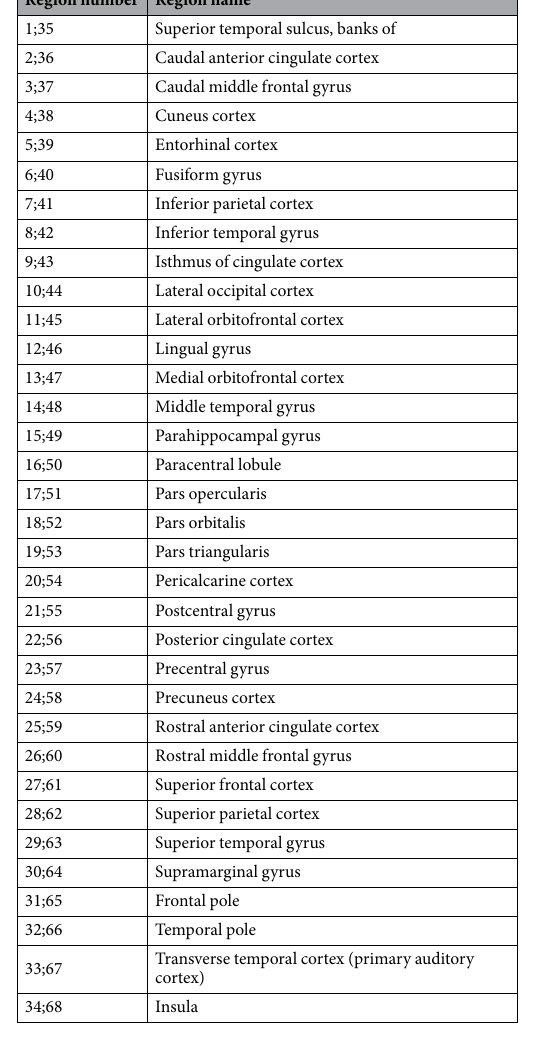
Table 1. Anatomical labels for the 68 regions in the Desikan-Kahilly parcellation. The two region numbers per line refer to right and left hemisphere